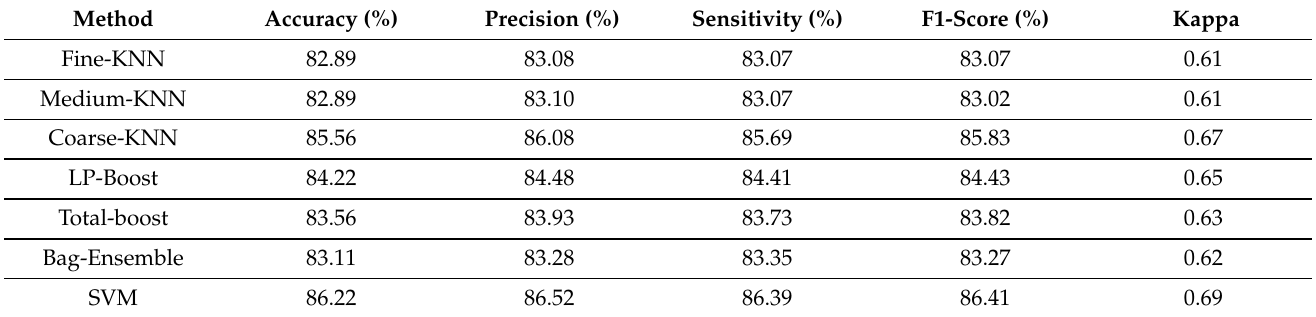
Table 11. Results obtained using different ML classifiers on five-fold cross validation.